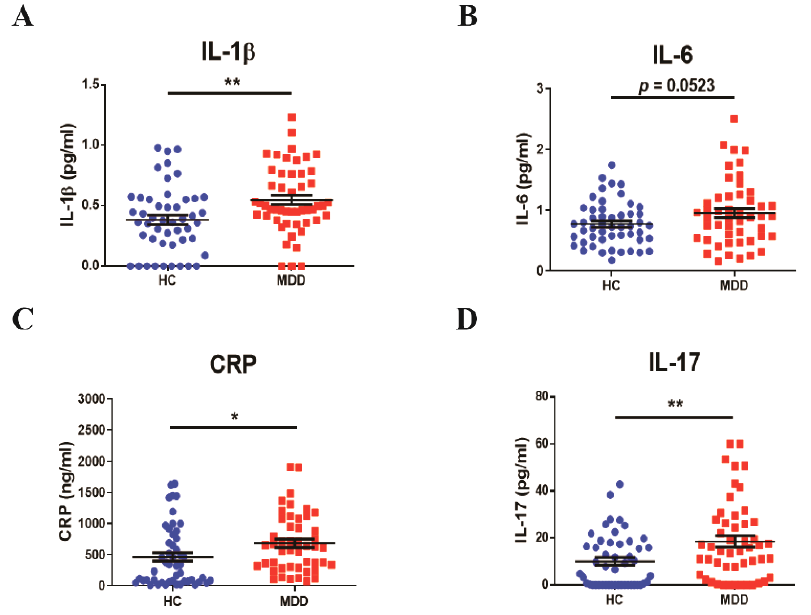
Figure 1 . The baselines of the inflammatory cytokines in young adult patients with major depression and in the age-matched controls. The concentrations of ( A ) IL-1β, ( B ) IL-6, ( C ) CRP, and ( D ) IL-17 in serum were quantified using the ELISA system. The serum was separated from peripheral blood in participants. n = 50 for each group. * p < 0.05 and ** p < 0.01 by two-tailed t -test. Data are presented as means ± SD.